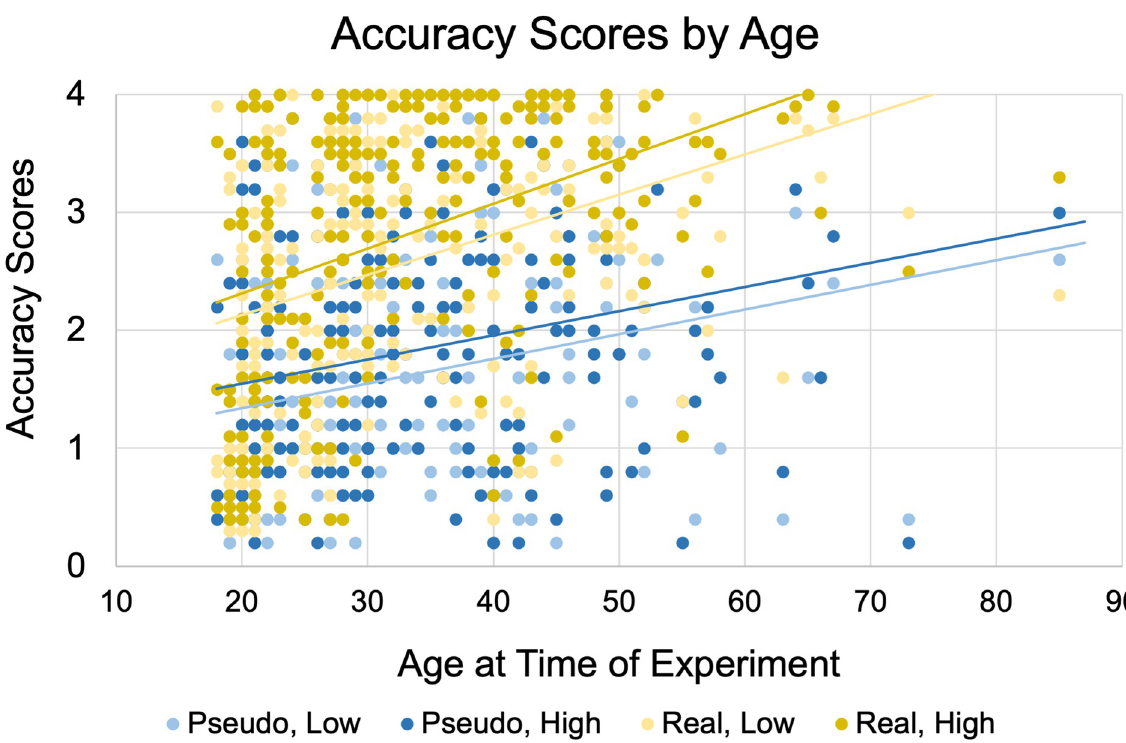
Fig 6. Accuracy scores plotted against participants’ age at the time of the experiment. Accuracy is divided into four categories based on Word Type (Pseudo and Real) and Number of markers (Low and High).